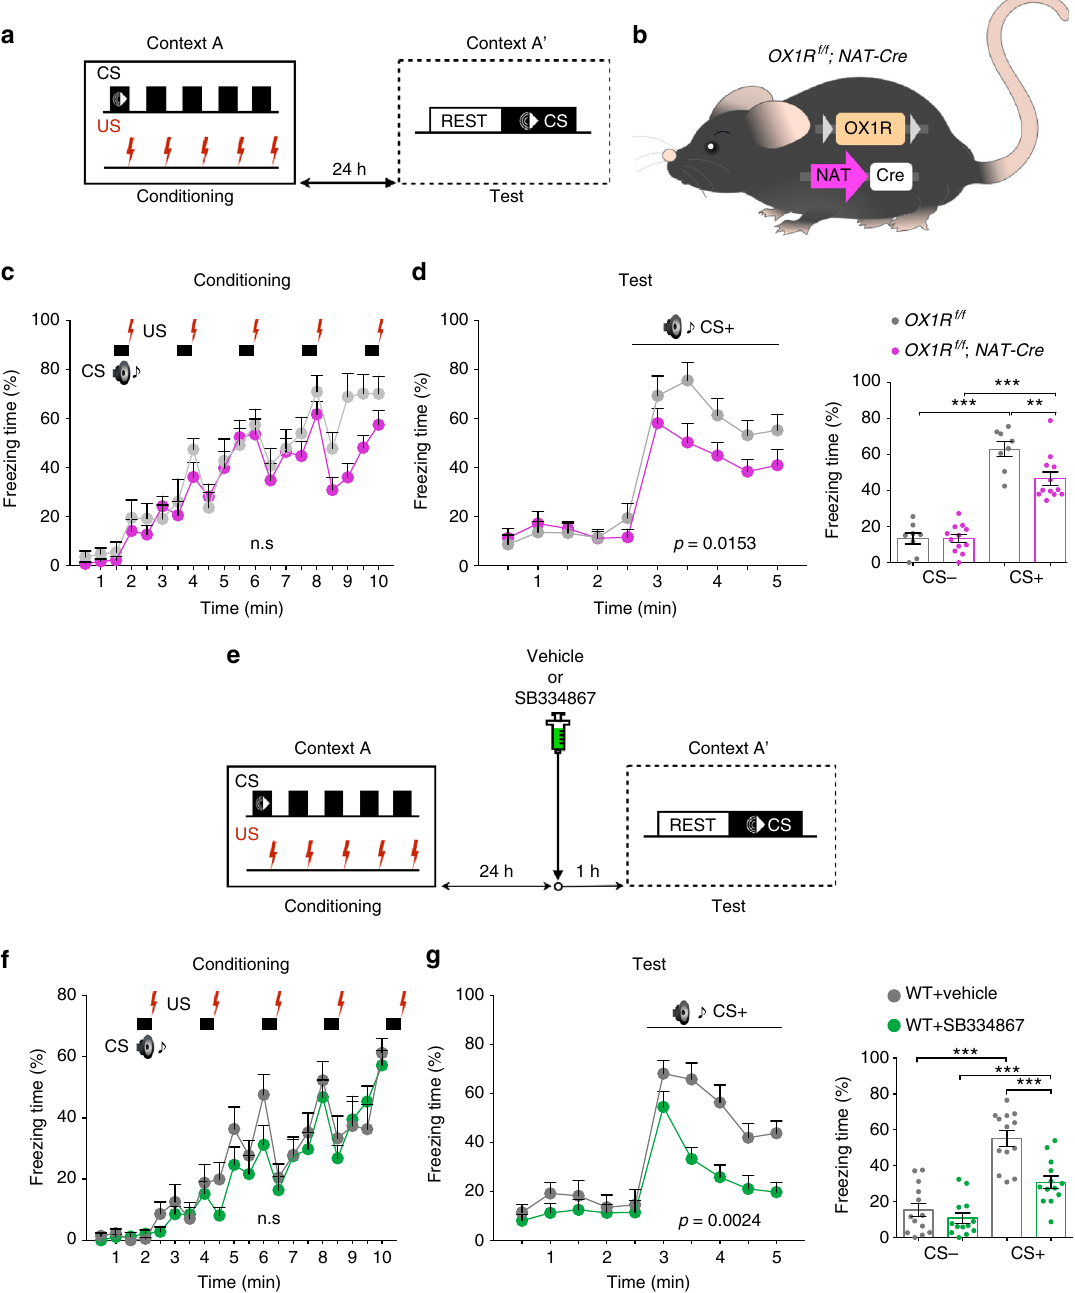
Fig. 1 Role of OX1R in NA LC neurons in cued fear memory retrieval. a Schematic drawing of fear conditioning paradigm used in this study. b Cell-type- selective deletion of OX1R in NA LC neurons. LoxP sites are introduced in the OX1R allele in OX1R f/f mice to delete exons 5 and 6 by Cre-mediated recombination. c , d After cued fear conditioning, OX1R f/f ;NAT-Cre mice reduced freezing responses in test session. e Pharmacological blockade of OX1R by OX1R antagonist (SB334867) in cued fear conditioning paradigm. f , g After cued fear conditioning, i.p. administration of SB334867 1 h before the test session signi fi cantly attenuated cued fear memory retrieval. ** p < 0.01, *** p < 0.001. Values are mean ±